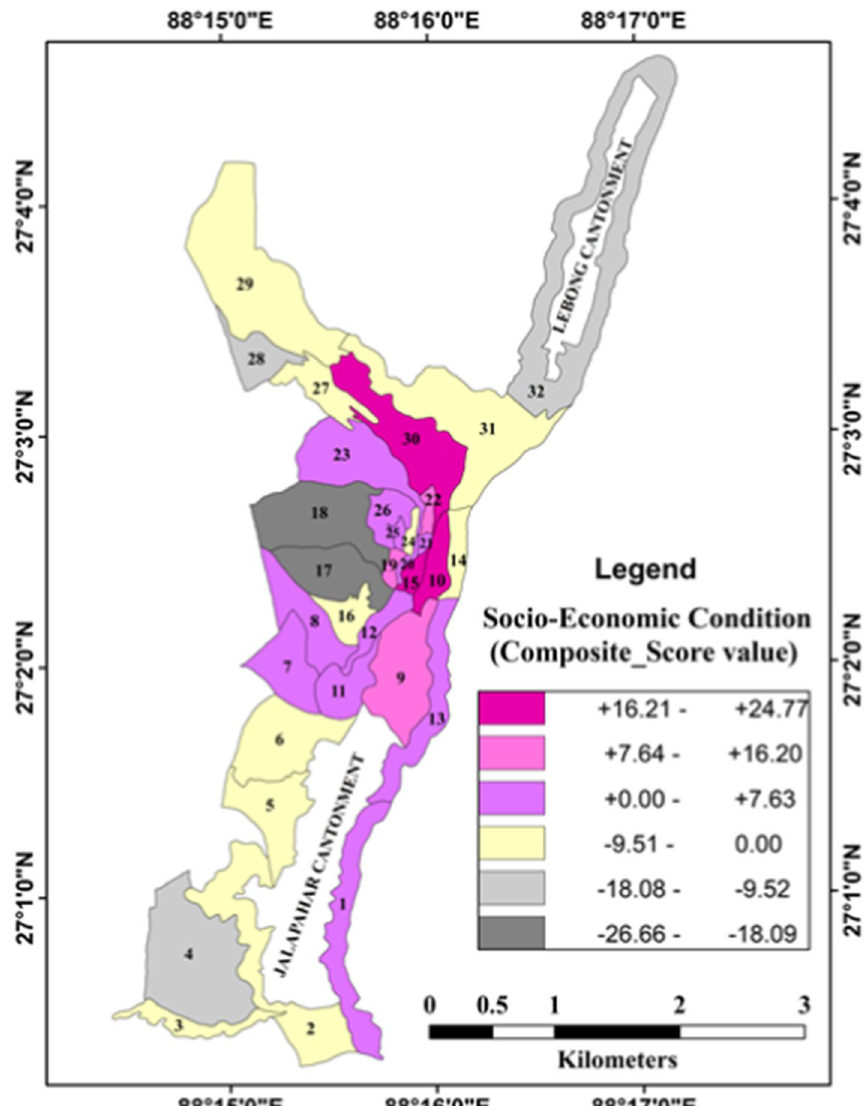
Fig. 5 Socio-economic condi-